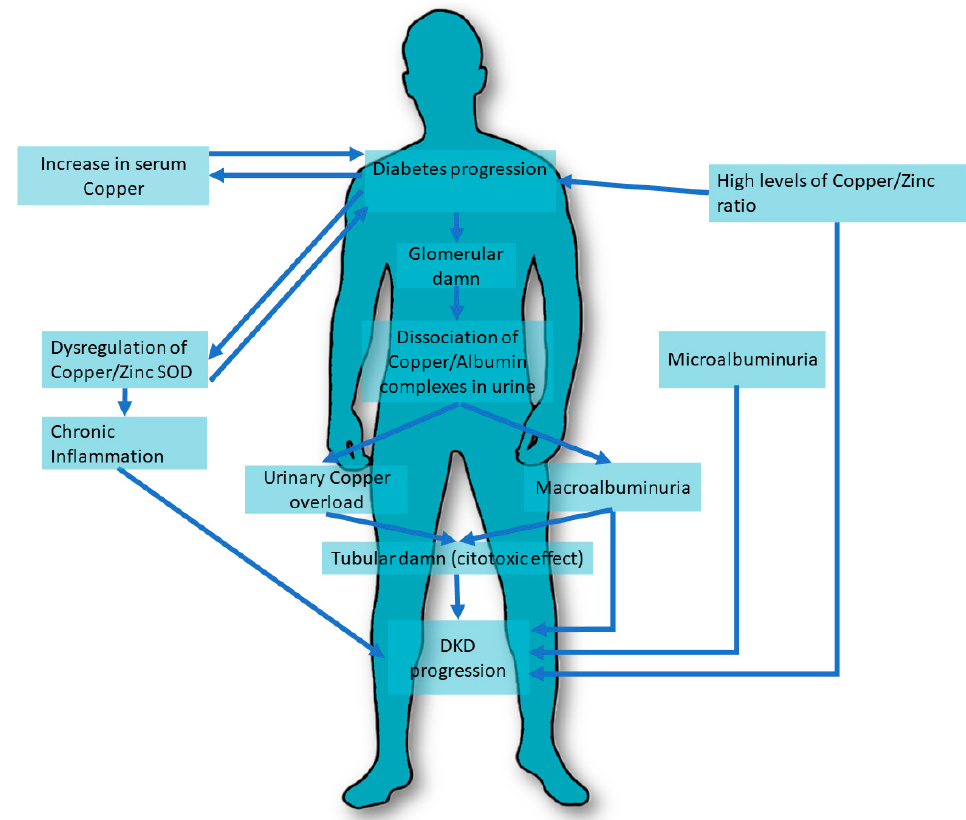
Figure 1. Copper pathways involved in DKD. DKD, Diabetic Kidney Disease. SOD, superoxide dismutase.